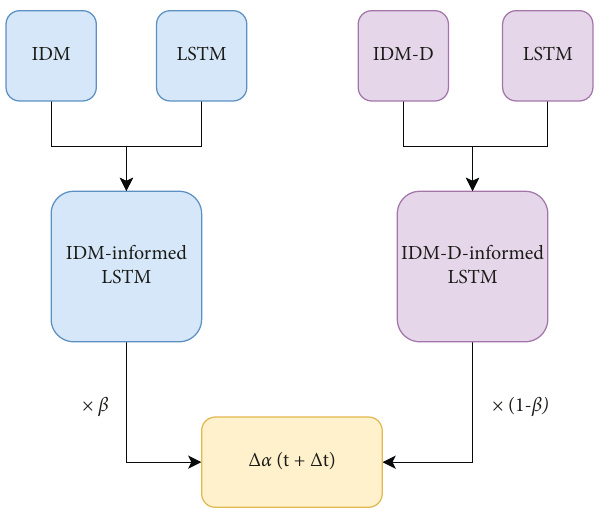
Figure 4: The structure of the FEHM.